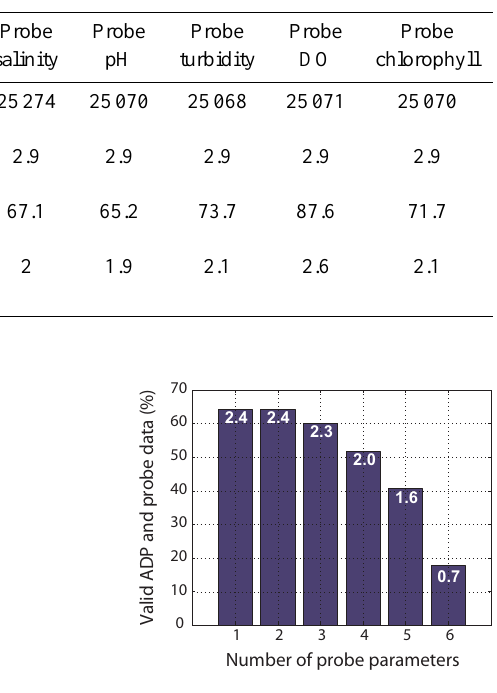
Figure 3. Percentage of valid (and accepted) ADP data (consider- ing here the main-cell north velocity component) that are concur- rent with valid probe data. The results are shown for one to all (six) probe parameters, at least, required to be valid at the time of the valid ADP records. The cumulative duration (in years) of combined valid ADP-probe data is shown on top of each